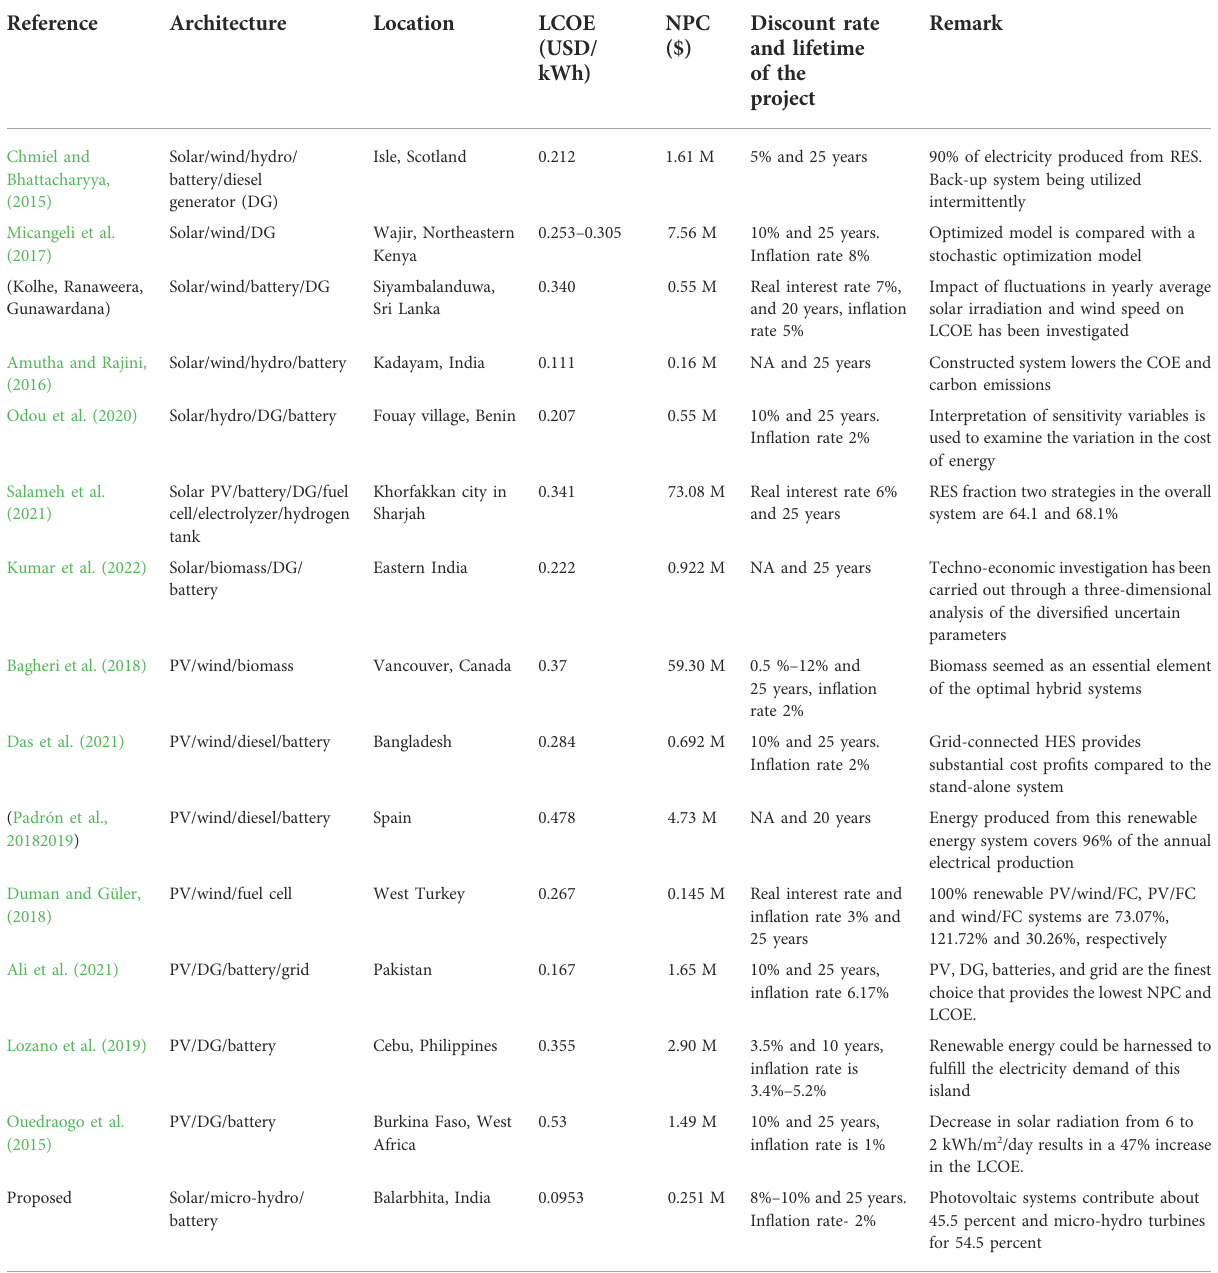
TABLE A3 Comparison of the proposed system with existing